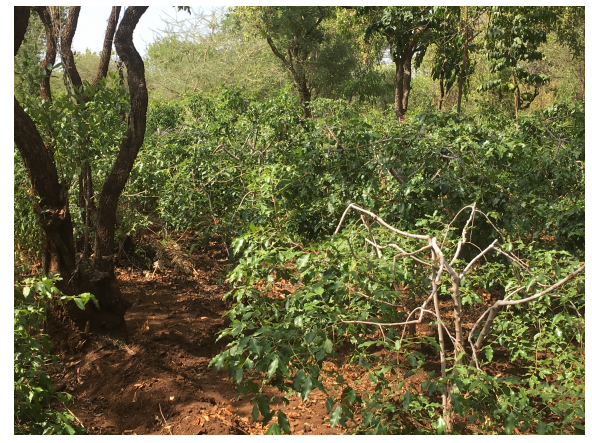
Fig. 3 . Commercial khat ( Catha edulis ) farm with small monocropped khat